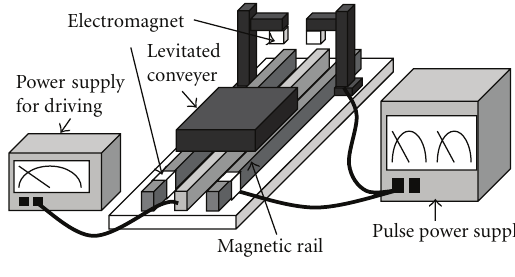
Figure 1: System.